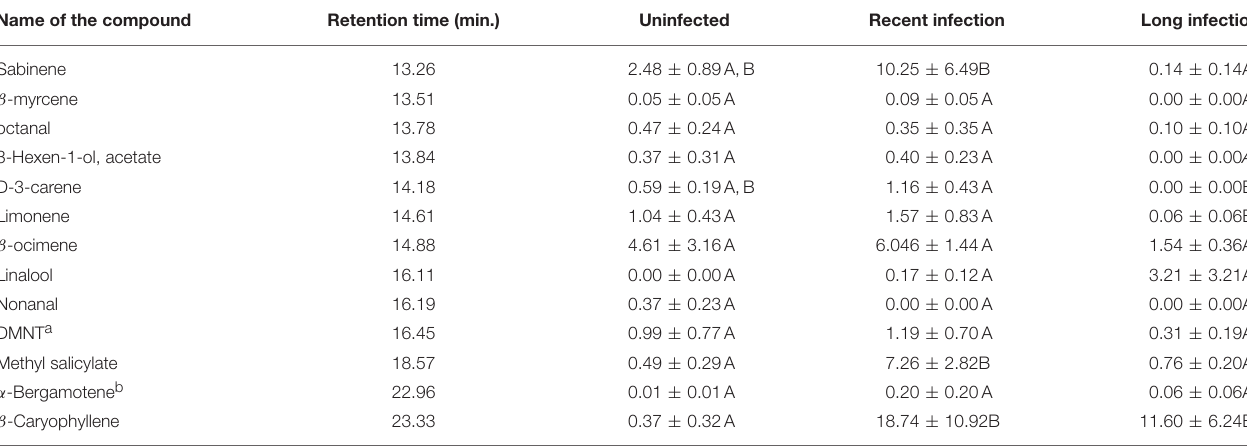
Numbers presented are averaged ratios between compound peak areas and internal standard (nonyl acetate) peak areas. Different letter indicate significant differences (P < 0.05) between